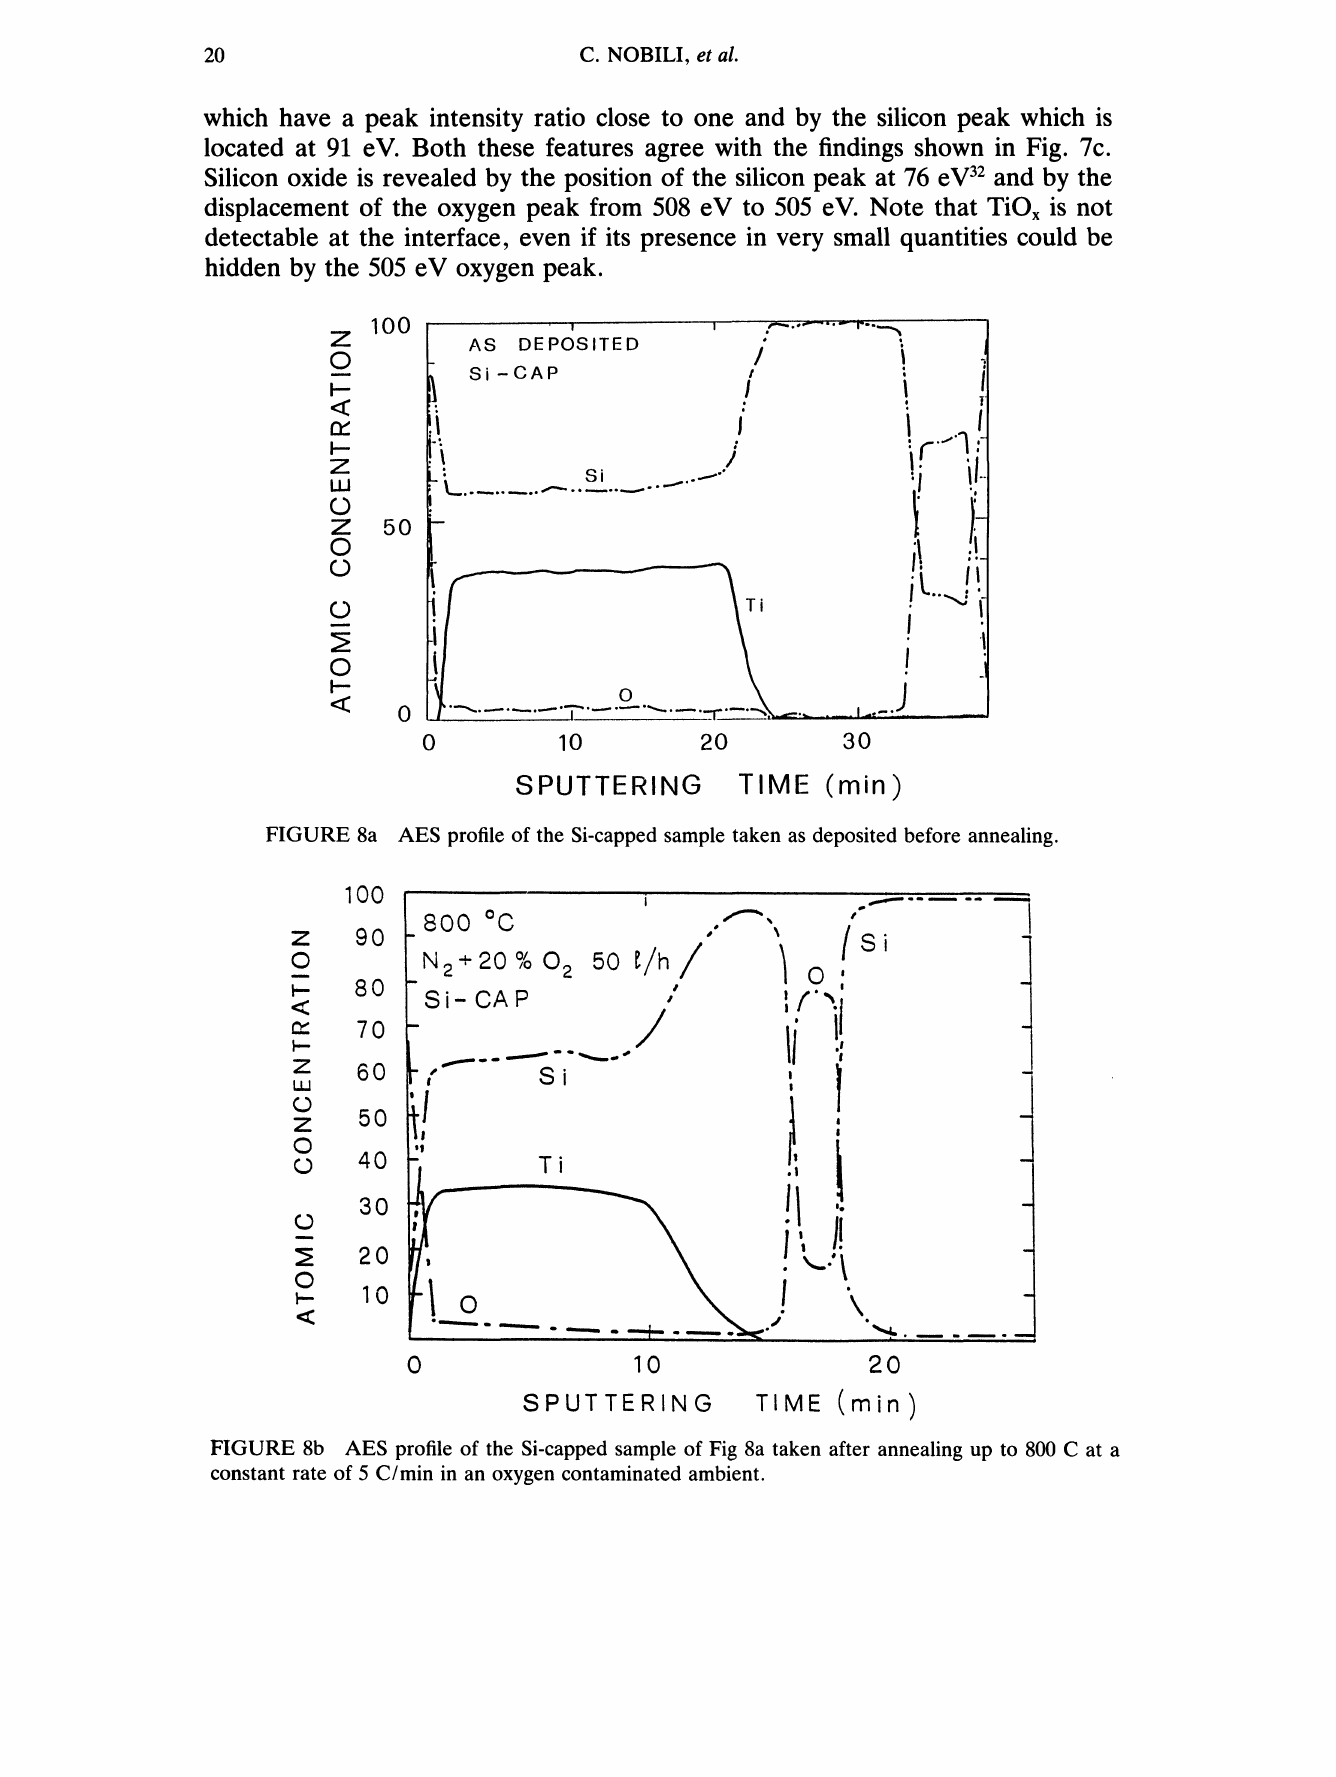
FIGURE 8b AES profile of the Si-capped sample of Fig 8a taken after annealing up to 800 C at a constant rate of 5 C/min in an oxygen contaminated